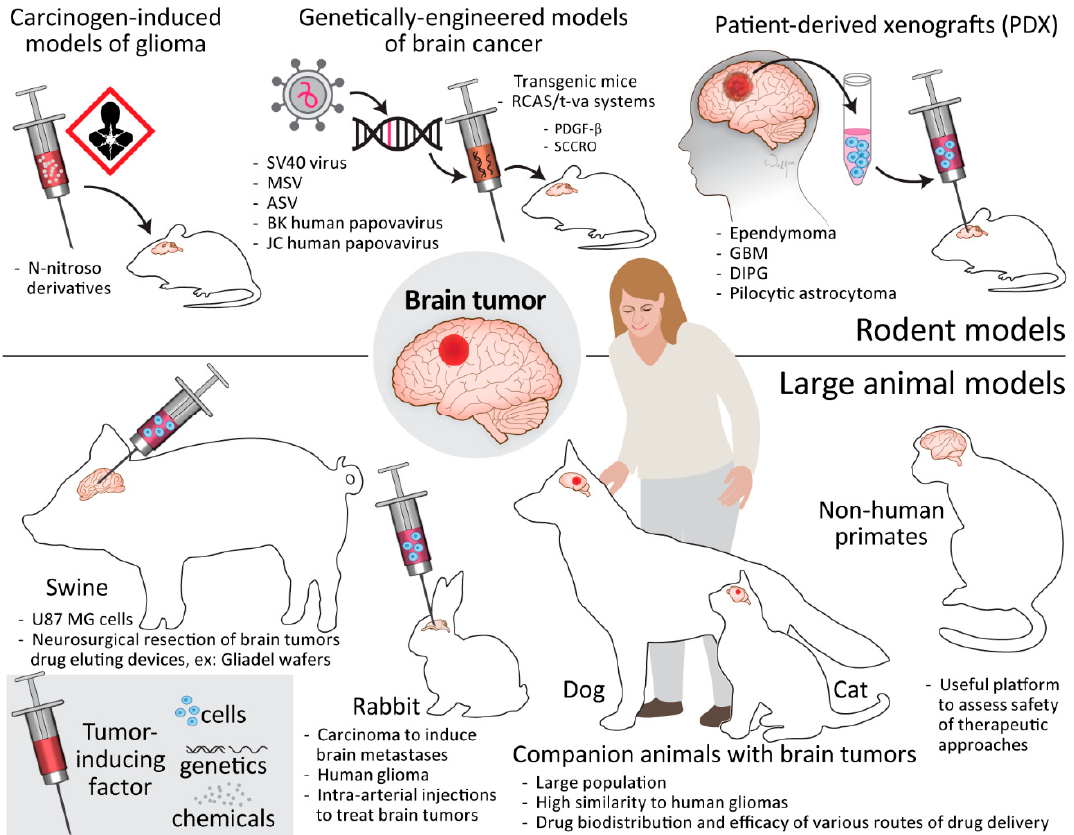
Figure 6. Suite of existing in vivo orthotopic brain tumor models. (Top) Carcinogen-induced, genet- ically engineered and patient-derived rodent brain tumor models. (Bottom) Large animal models including engineered (swine, rabbit) and naturally occurring de novo animals (dog, non-human primates) (original figure).